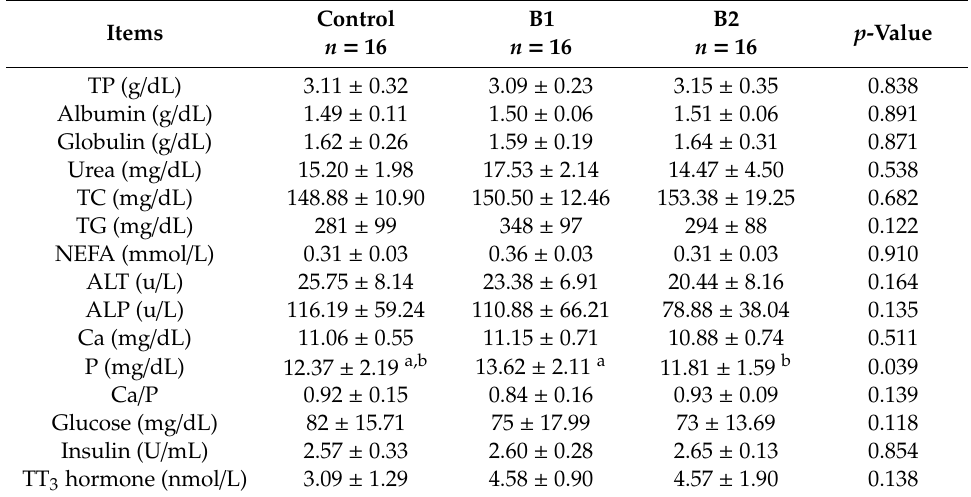
Table 3. The e ff ect of prebiotic Bi 2 tos ® on biochemical blood parameters in serum of common carp ( Cyprinus carpio